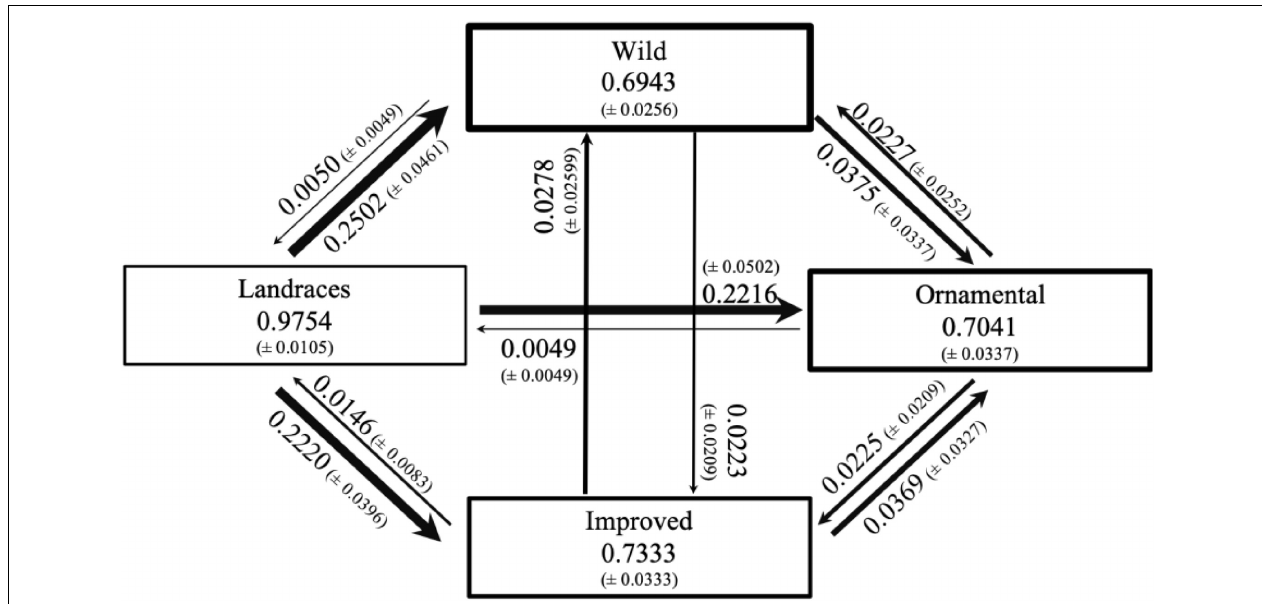
FIGURE 4 | Contemporary gene flow rates between subspecies and cultigens of C. pepo estimated with BayesAss. Numbers within boxes show proportions of individuals that remain within the sample (non-migrant individuals). The arrows specify the direction of gene flow between pairs of varieties. Values on the arrows indicate the proportions of immigrant individuals. The numbers in parentheses show the standard deviation of the marginal posterior distribution for each estimate.